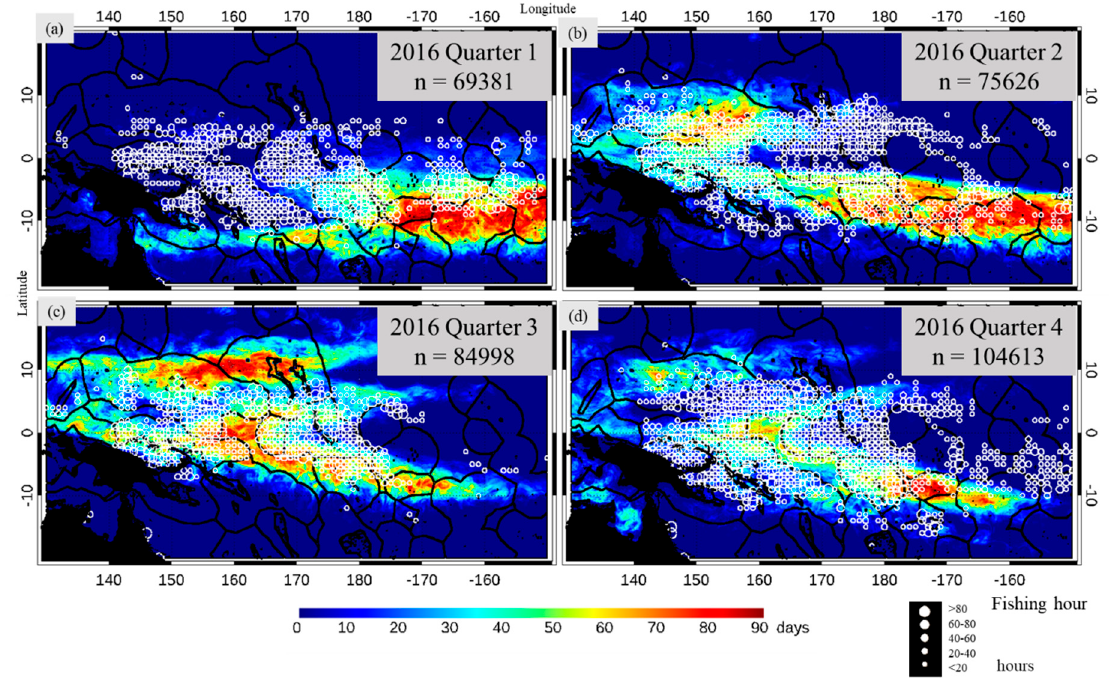
Figure 5. Fishing hours of global datasets of 1 ◦ Spatial grid with habitat variation. The quarterly habitat is defined by the presence of habitat suitability index (HSI) values and shows the occurrence accumulation: ( a ) quarter 1, ( b ) quarter 2, ( c ) quarter 3, and ( d ) quarter 4 in